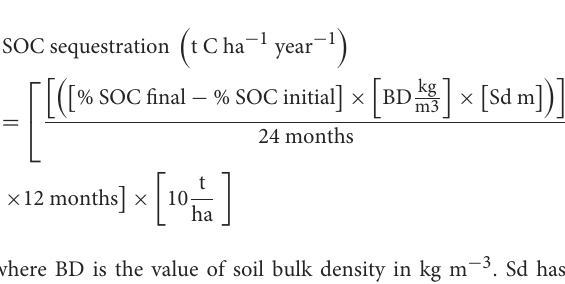
TABLE 2 Cultivar, plant density, inter- and intra-row distance, planting, harvesting, and soil sampling dates (2018–2020) for different winter and summer crops used in the experiment. Plant Cultivar